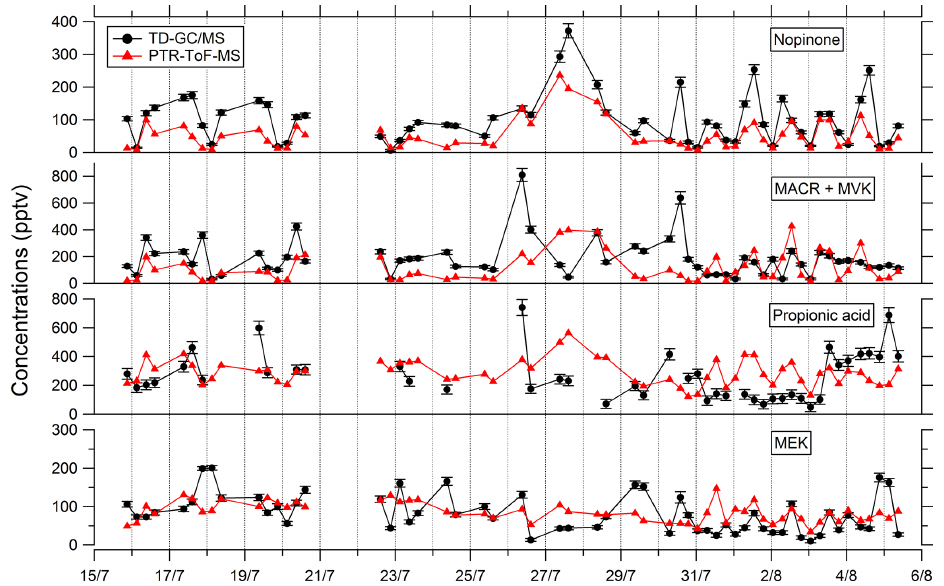
Figure 4. Comparison of ATD–GC–MS (automatic thermal desorption–gas chromatography–mass spectrometer) data with PTR-ToF-MS data averaged over the same time step for nopinone, the sum of methacrolein and methyl vinyl ketone, propionic acid, and methyl ethyl ketone. Error bars correspond to the 1 σ uncertainties in TD–GC–MS measurements.